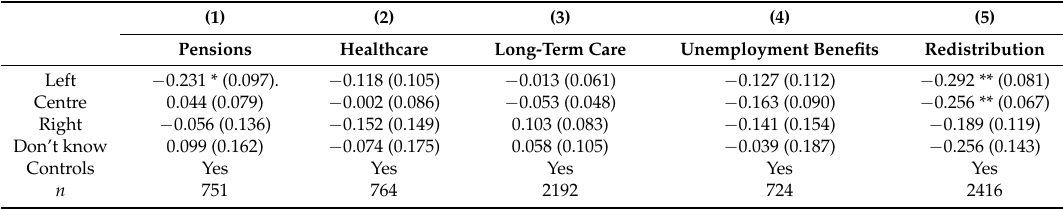
Table 3. Marginal effect of the tax constraint across partisan groups.